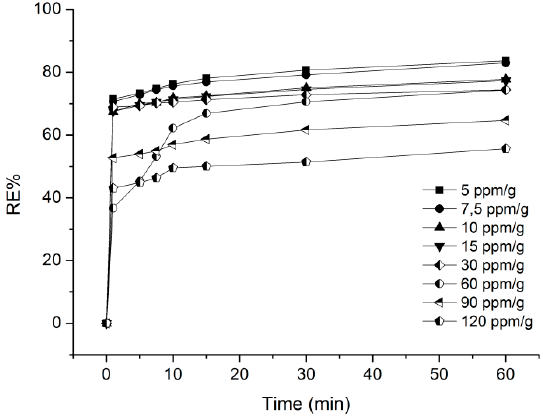
Figure 5. Process efficiency (%) in terms of BPA removal at various C 0 / W (i.e., initial BPA concentration/fiber mass) ratios. Experimental conditions: water volume = 50 mL; pH = 5. The errors in the calculated removal efficiency are in the range from 0.11 to 1.17%.